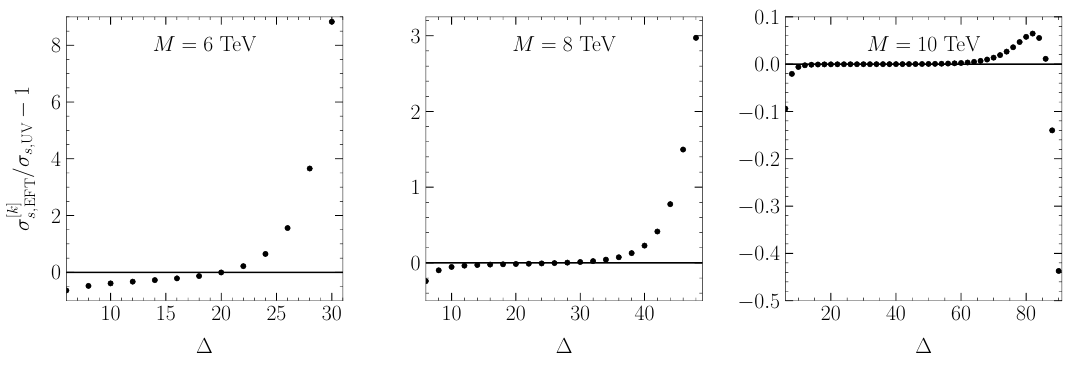
Figure 15 . The relative error (see eq. (5.10)) as computed for the s -channel model in the “Hadronic √ s = 14 TeV and m φ = 1 TeV. Initial State” case for M <